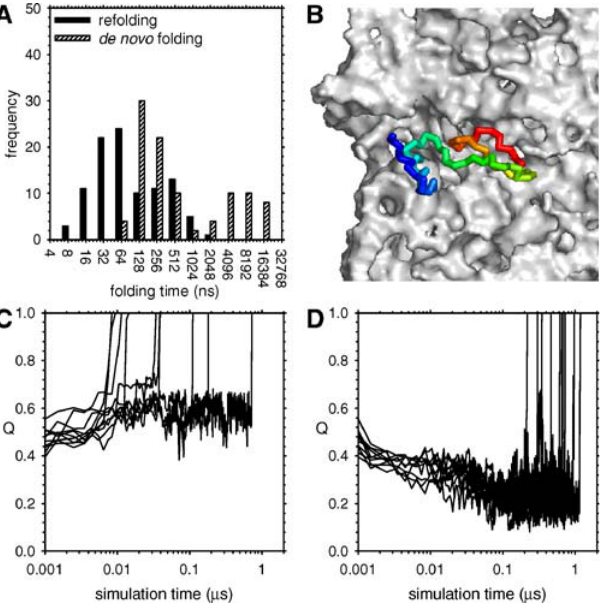
Figure 8. Consequences of Excessively Stabilizing CI2 (A) Histograms of folding times obtained from refolding and de novo folding trajectories of CI2 with e ¼ 0.80 kcal/mol. (B) Snapshot of a ‘‘ trapped ’’ trajectory. (C) Plots of Q versus time for ten previously trapped trajectories when restarted without the ribosome. (D) Same as (C), but restarted with the ribosome and e ¼ 0.60 kcal/mol. DOI: